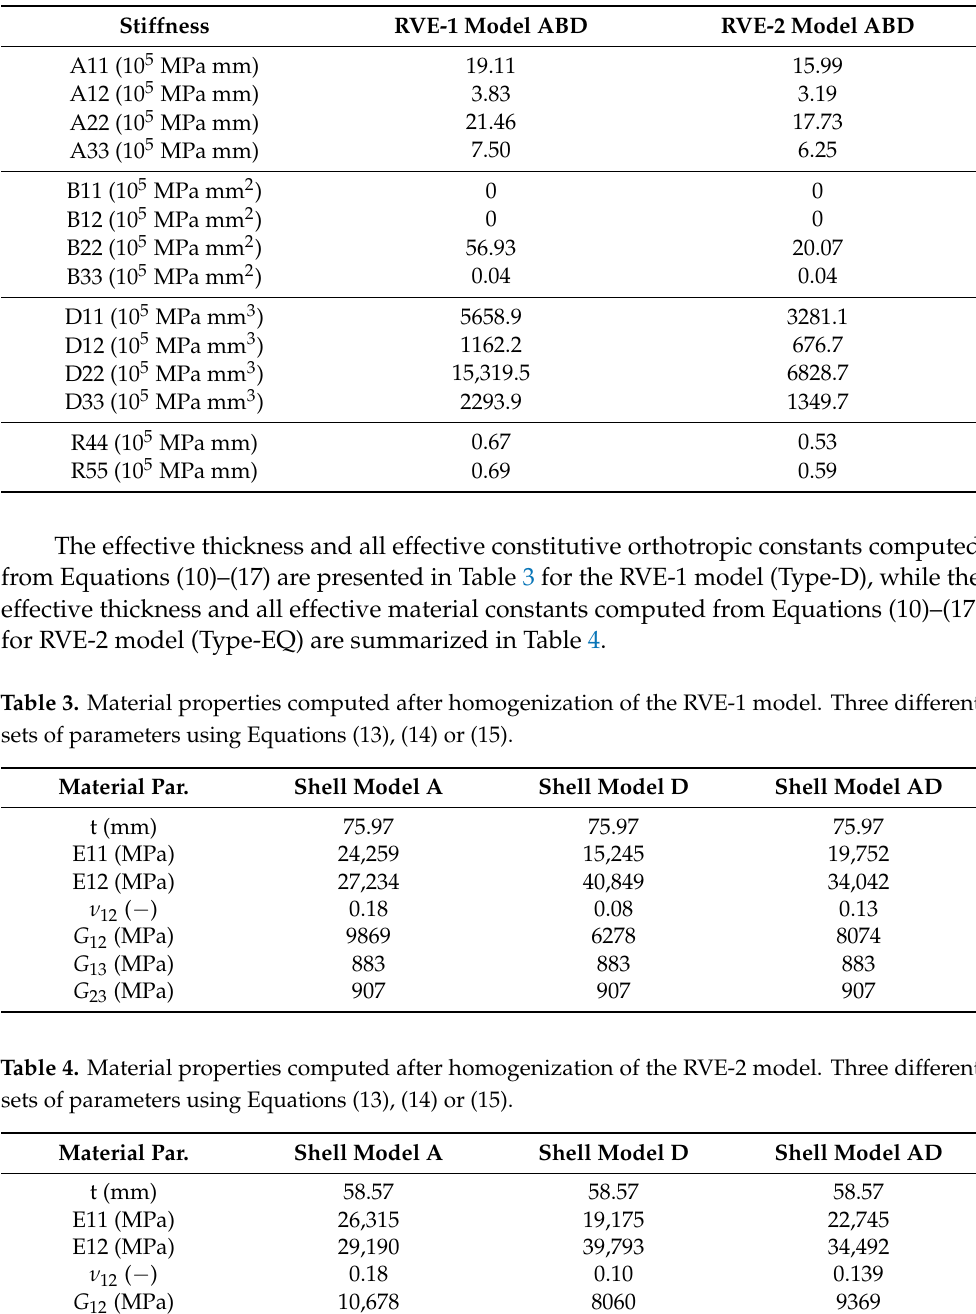
Table 2. ABD stiffness matrix for RVE-1 and RVE-2 models.